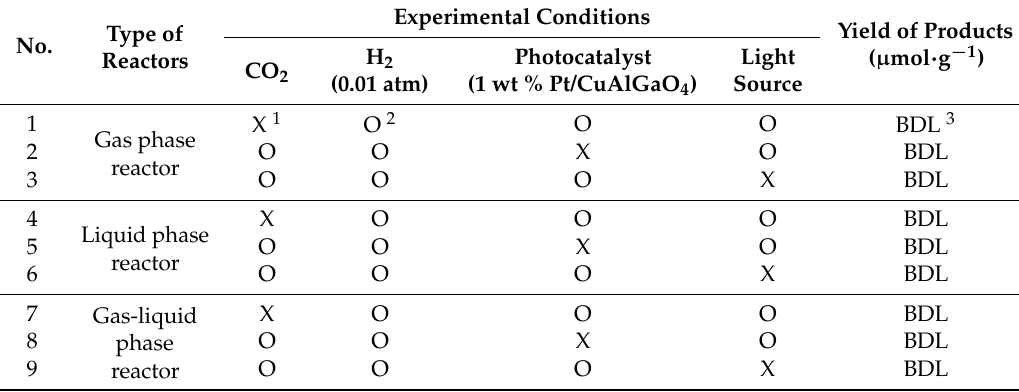
Table 3. Summary of blank tests for photo-hydrogenation of CO 2 .